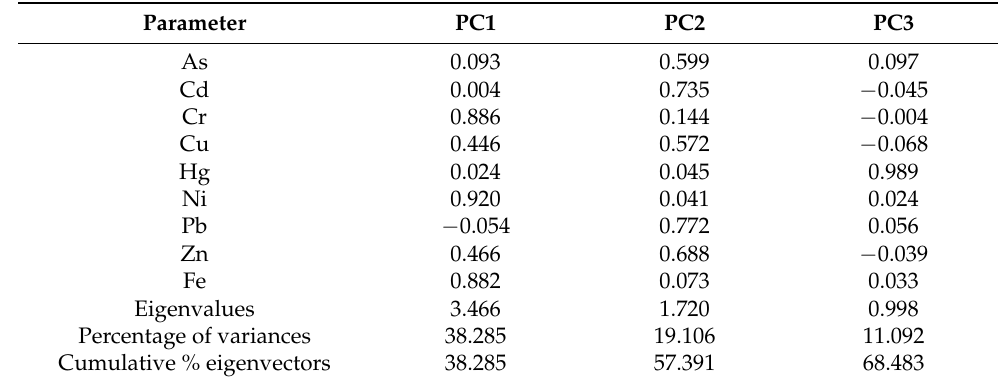
Figure 9. Loading plot of principal components (PCs) for heavy metals in surface soils of the study area using principal component analysis (PCA) after varimax rotation. Table 10. Loading of surface soil and eigenvalues, percentage of variance, and eigenvectors for the three principal components (PC1, PC2 and